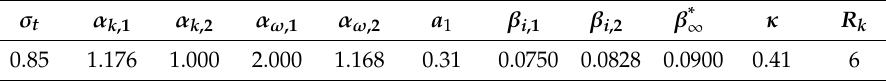
Table 1. Values of constants in the SST k– ω turbulence model